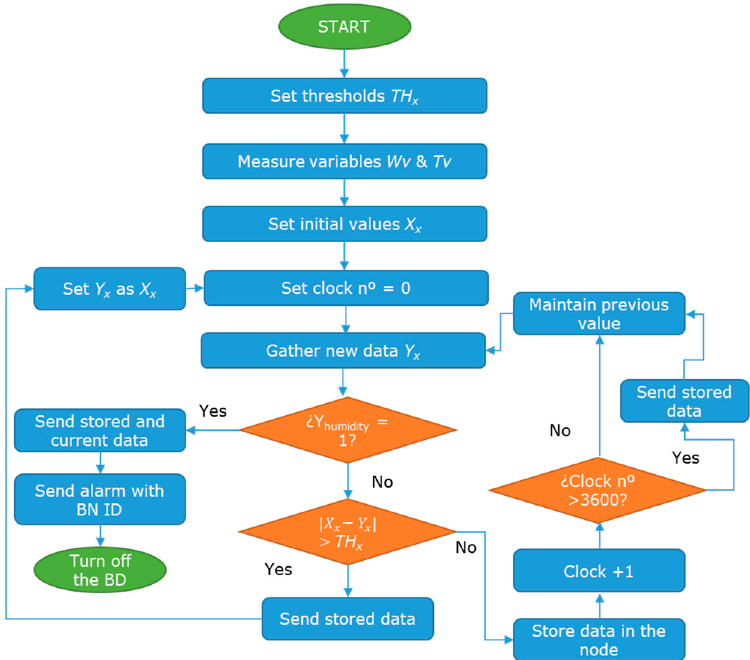
Figure 3. Operation algorithm for the water variables and tank variables.